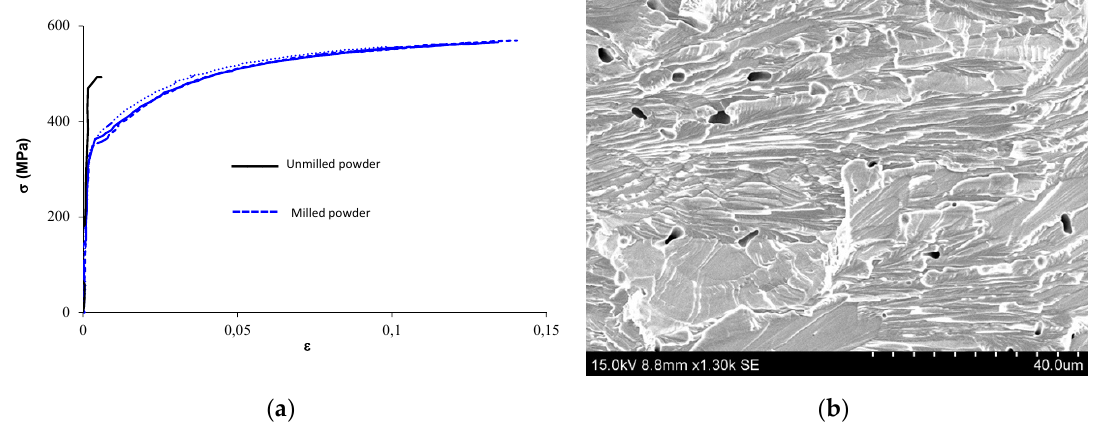
Figure 17. ( a ) True tensile stress strain curves of molybdenum samples sintered from unmilled and milled powder ( b ) SEM image of fracture surface of a sintered milled powder.